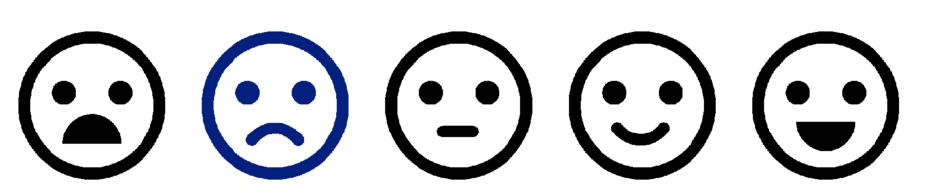
Figure 3. “5-faces” widget. The picture is presented with a negative filter.